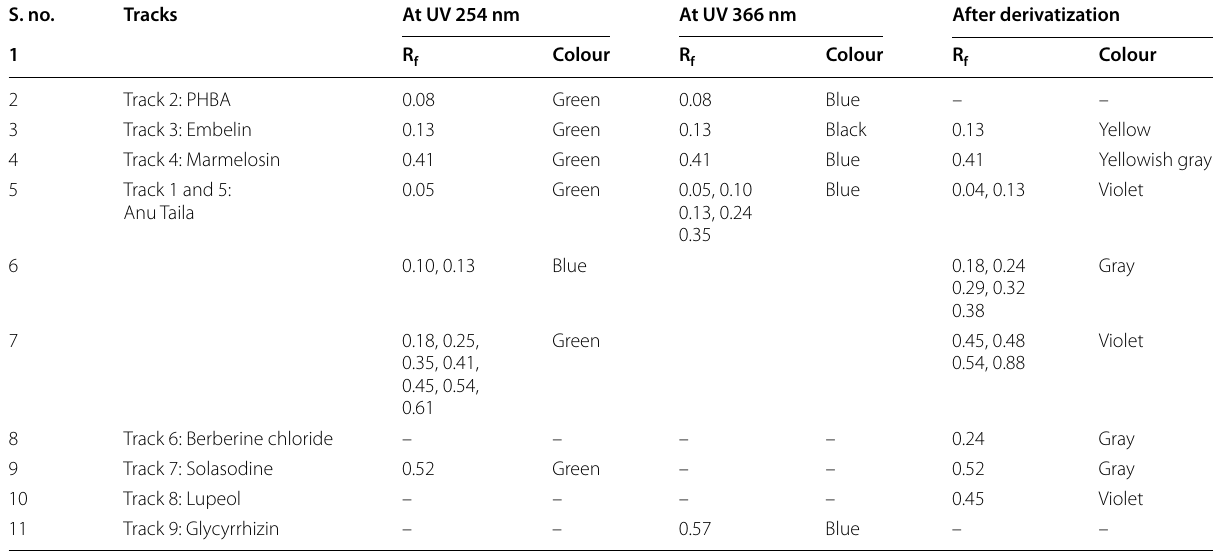
Table 2 R values of various biomarkers and Anu Taila f S. no.